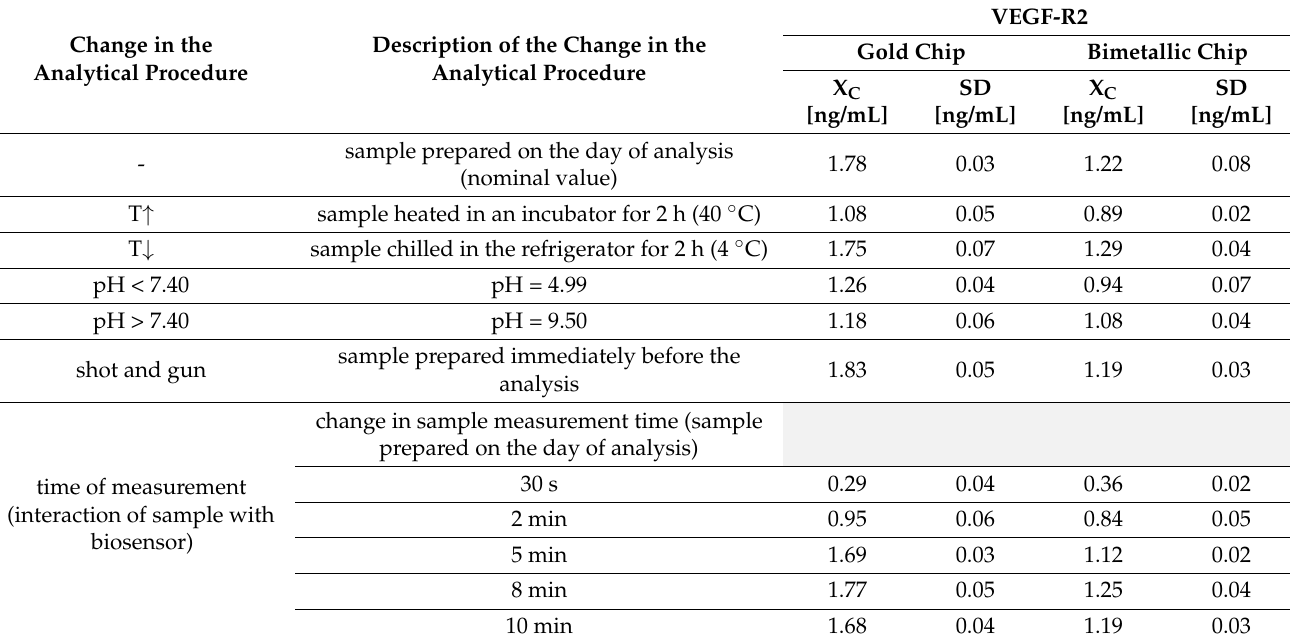
Table A1. Effect of changes in the analytical procedure on the value of the quantification result.